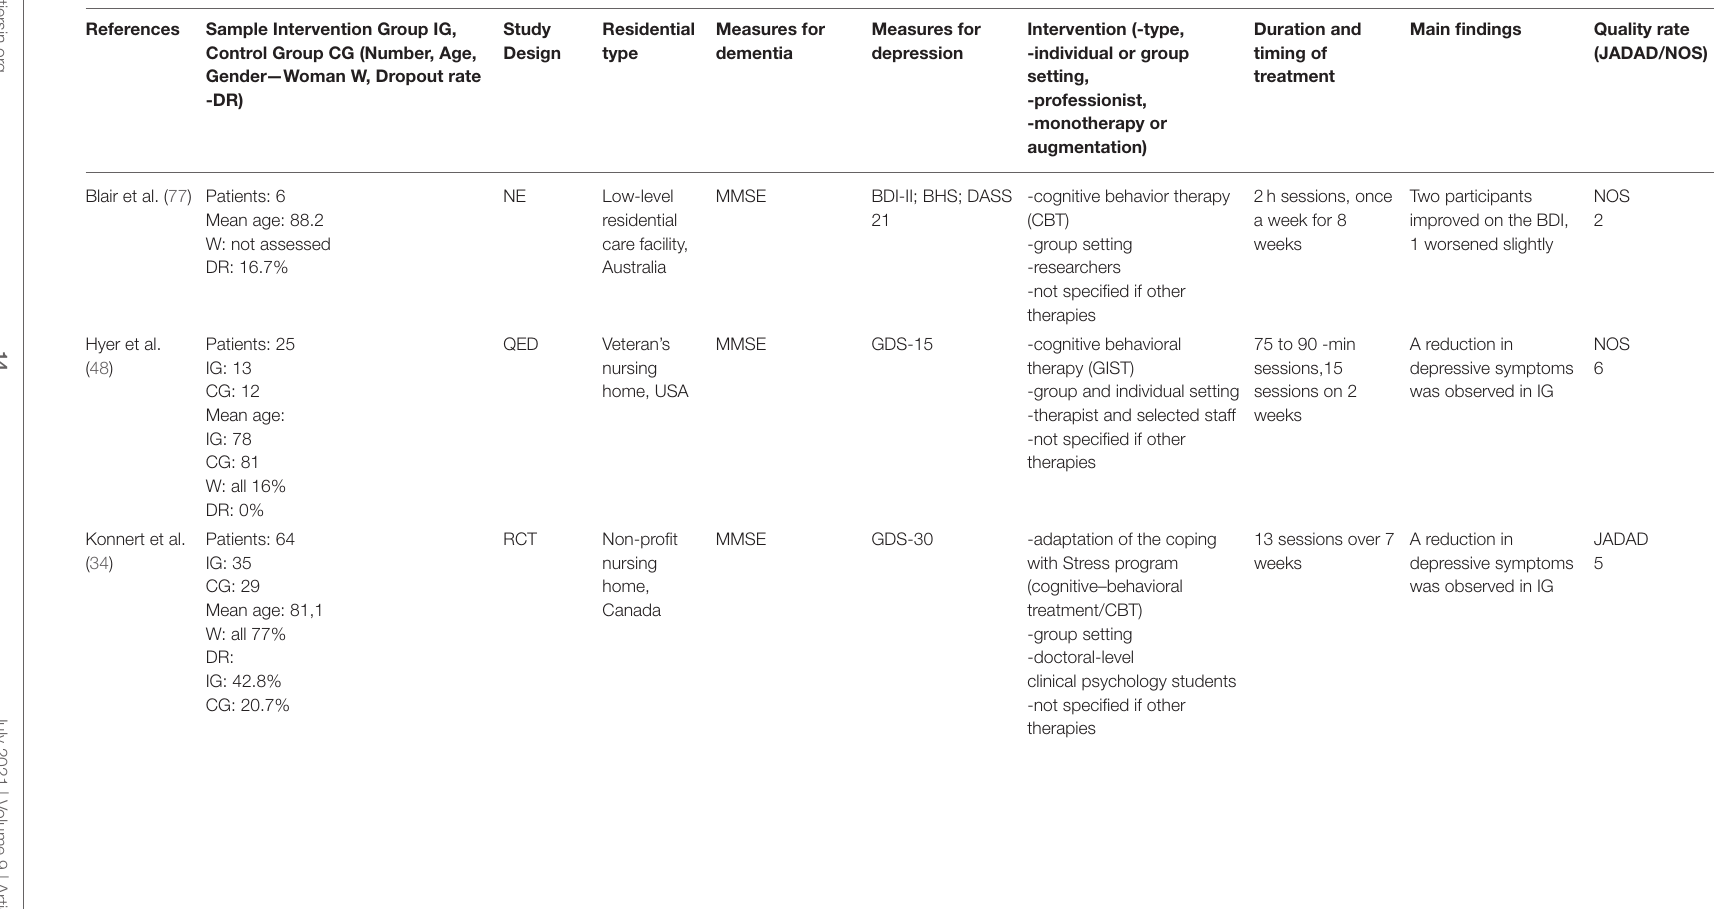
TABLE 5 | Psychotherapy studies (n 3 articles). Sample Intervention Group IG, Control Group CG (Number,